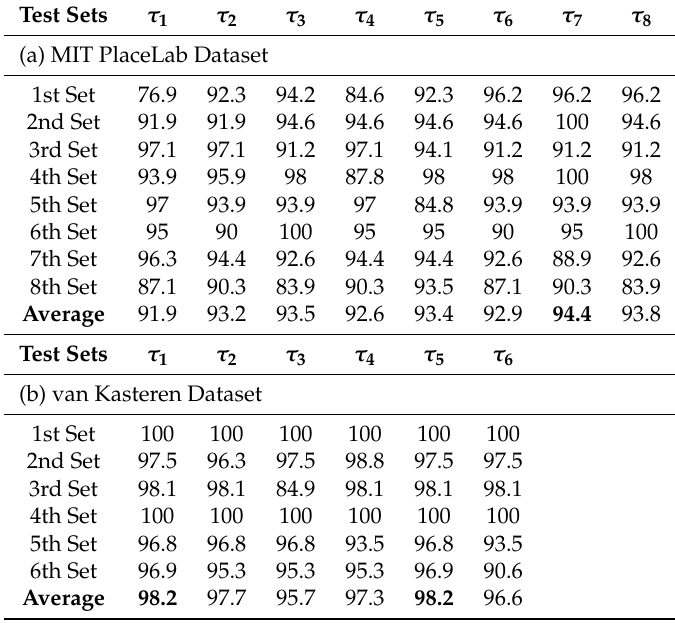
Table 3. Recognition accuracy of decision trees trained on different test